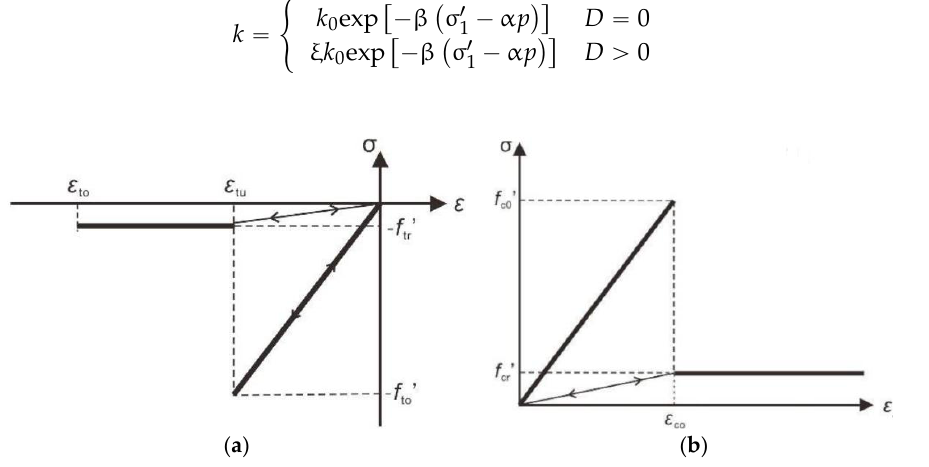
Figure 1. Elastic-brittle damage constitutive law of element subject to uniaxial stress: ( a ) the case under uniaxial tensile stress; ( b ) the case under uniaxial compressive stress.